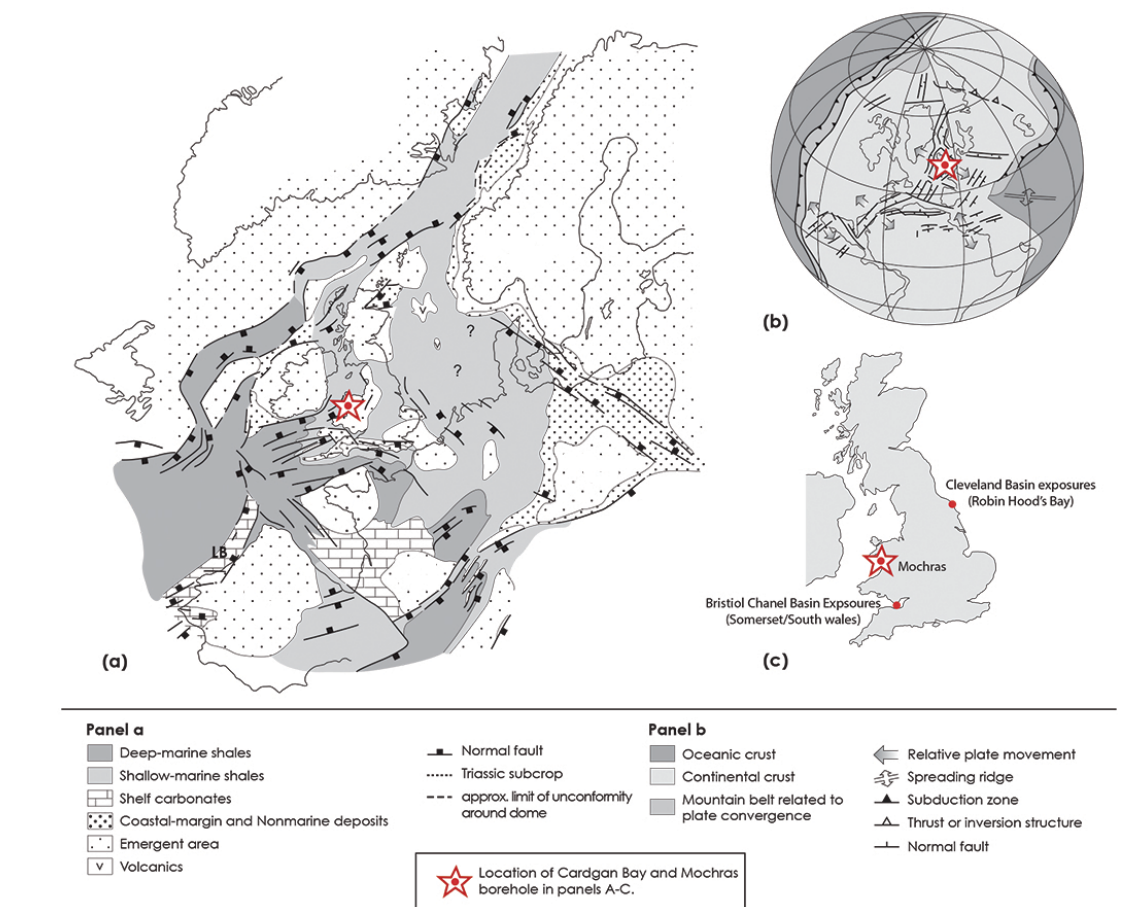
Figure 1. Palaeogeographic setting of the first Mochras borehole (modified from Coward et al.,